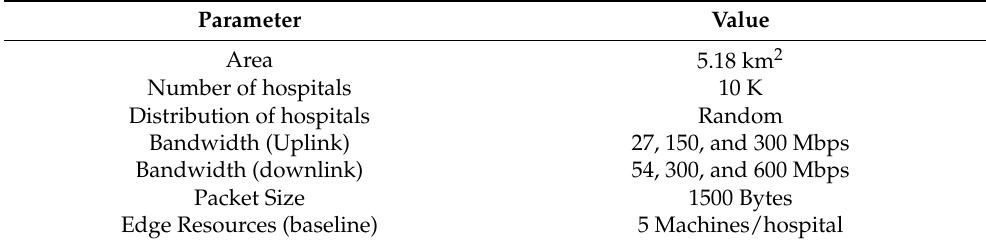
Table 4. Simulation